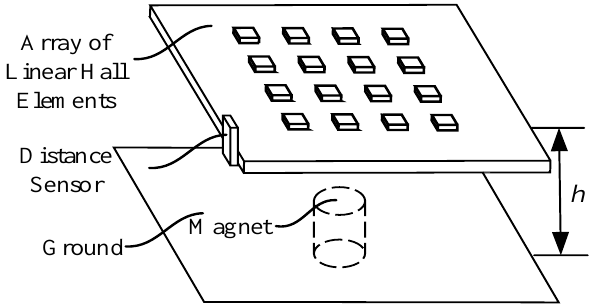
Figure 1. Magnetic positioning device diagram.